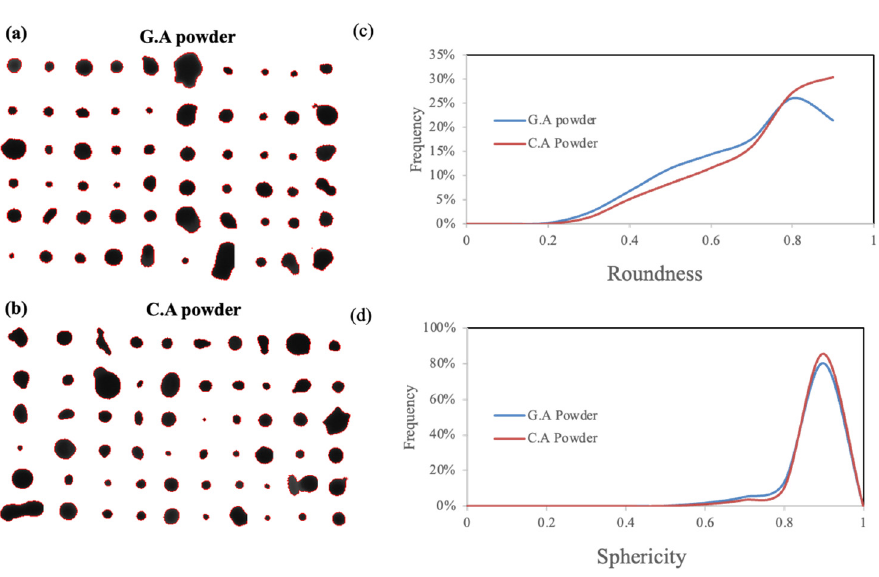
Figure 4. Snapshot of the powder particles from the shape analyzer: ( a , b ) roundness, ( c ) sphericity and ( d ) distributions of both powders.